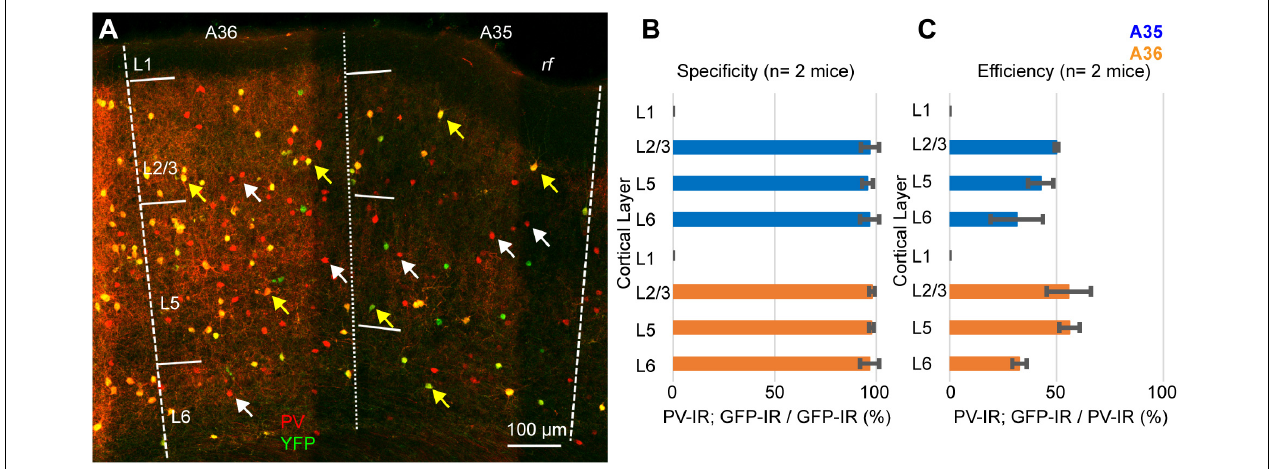
FIGURE 5 | (A) Representative confocal stack showing the overlap of immunofluorescence for PV (red) and YFP (green) in PER. Yellow arrows indicate double-IR neurons, white arrows indicate PV-IR neurons not labeled with YFP. (B) Bar graph showing the specificity of the mouse line in 2 animals. (C) Bar graph showing the efficiency of the mouse line in 2 animals.